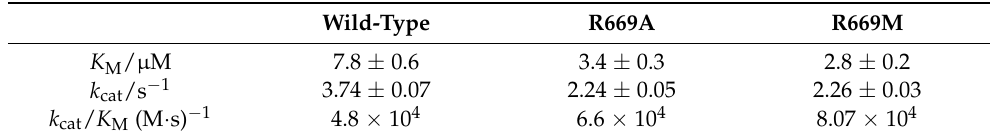
Table 3. Results of the Michaelis – Menten test for the hydrolysis of Arg 2 -2NA in the presence of DPP